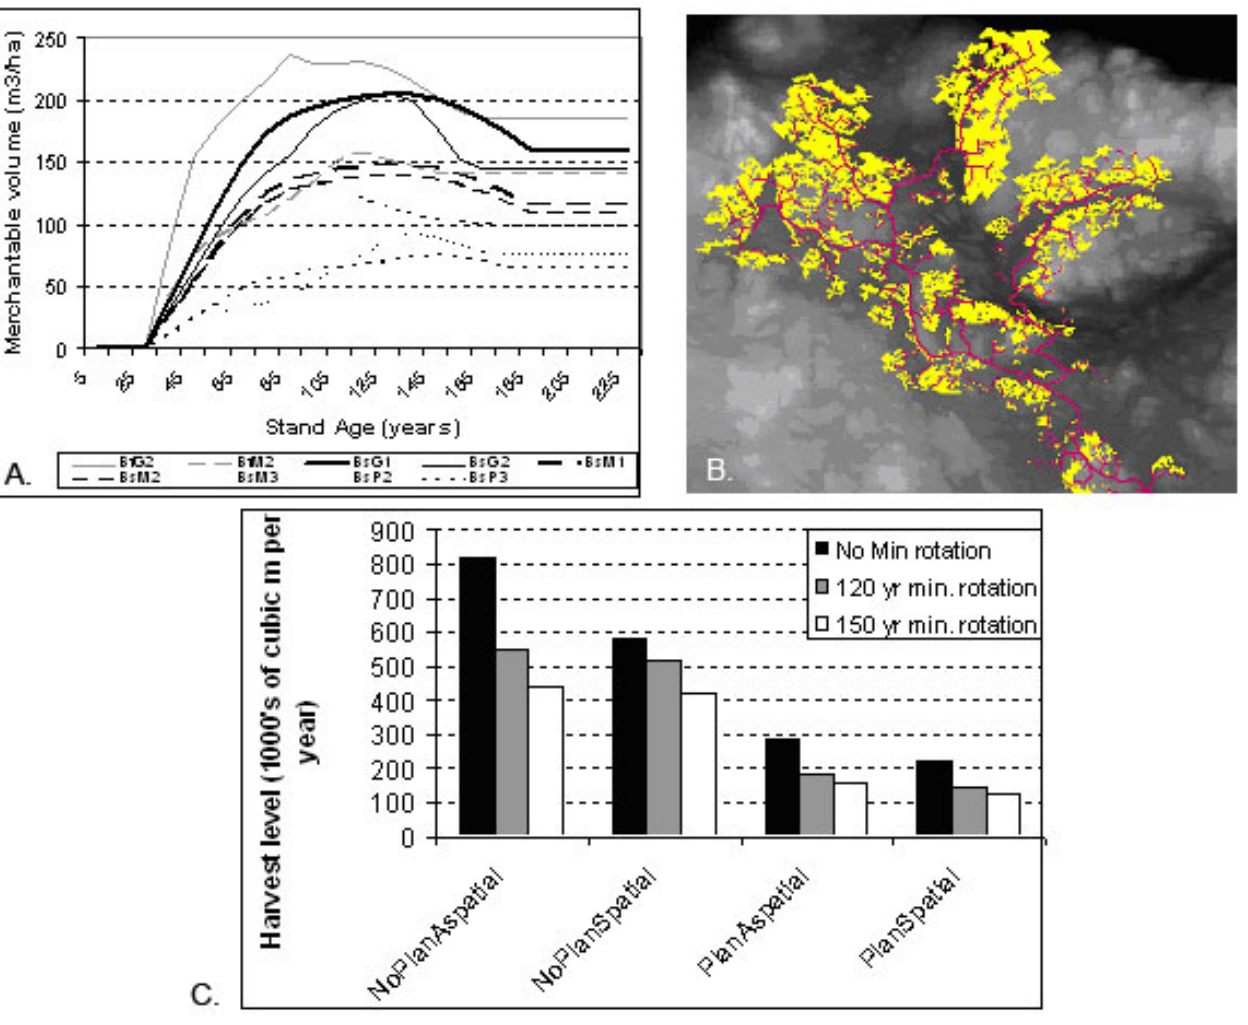
Figure A1. a. Empirical growth and yield curves for Labrador, used as input for the D19aLM model to project timber supply. Individual yield curves represent species and “site types” combinations for “high boreal” ecoregion, where the first two letters represent the species (Bf = balsam fir; Bs = black spruce), the third letter is the site quality (G = good; M = medium; P = poor), and the last number is the crown closure class (1 = > 75%; 2 = 51-75%; 3 = 26-50%). b. Simulated forest “cutblocks” (yellow) dependent on an expanding road network (magenta), overlaid on a digital elevation model. c. D19aLM output showing maximum annual allowable cut in response to different combinations of constraints: No plan versus the 20-year plan (i.e., “Plan”); spatial constraints (i.e., within 2km of roads, including new road placement) versus no spatial constraints on harvesting (“Aspatial”); no minimum rotation period versus 120 and 150 year minimum stand